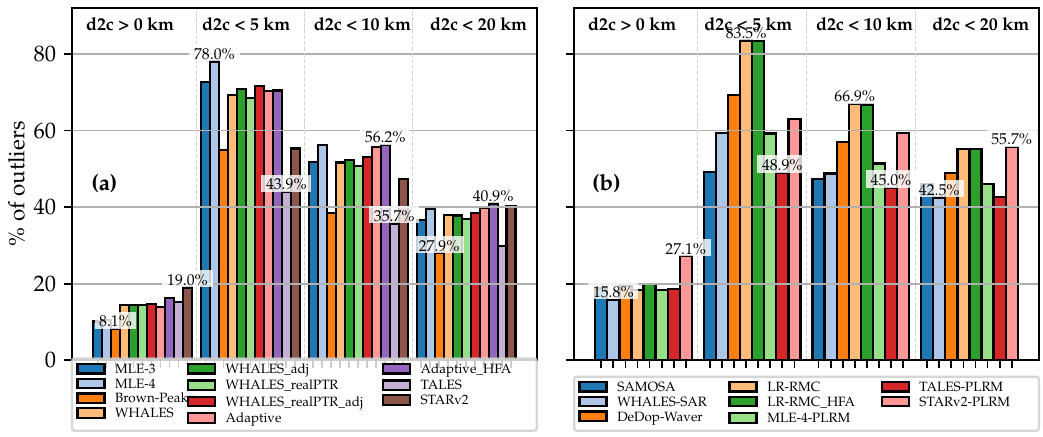
Figure 3. The total number of outliers as a function of dist2coast for ( a ) J3 and ( b )